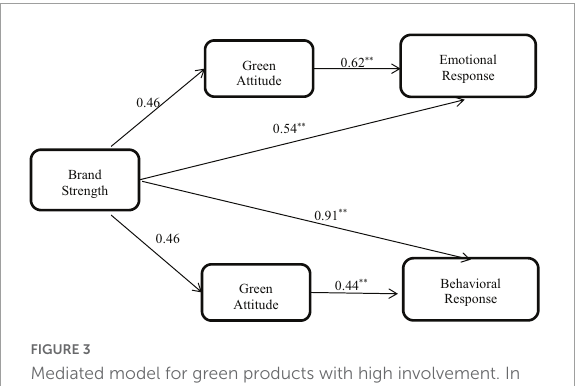
FIGURE3 Mediated model for green products with high involvement. In estimating the model, we tested a mediated effect. ∗∗ p < 0.01.